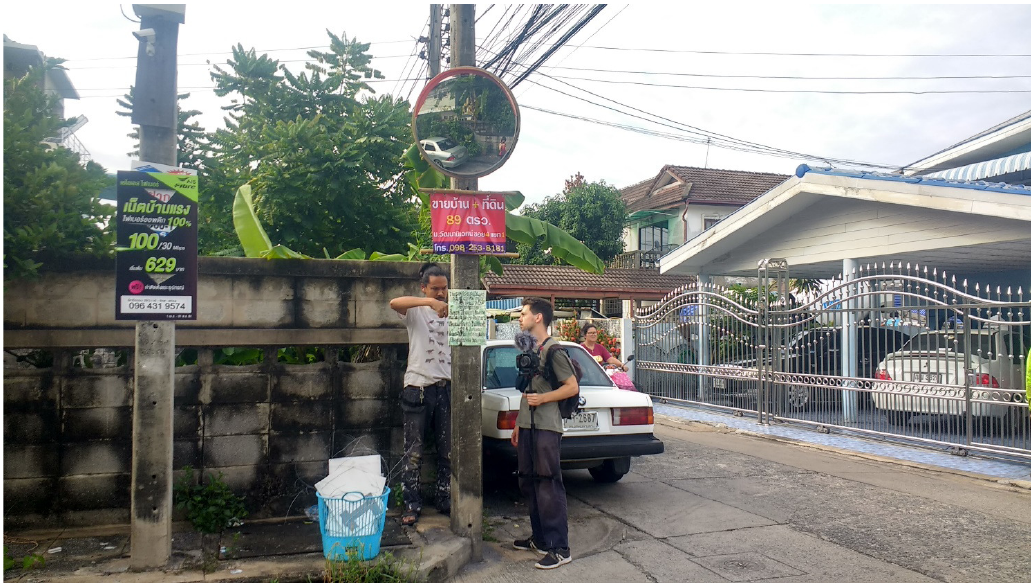
Figure 7. Ekarat Tosomboon and Michaël Harpin hanging posters requesting broken pots in the Hong HUB neighbourhood (July 2018). Photo courtesy of Hong HUB.